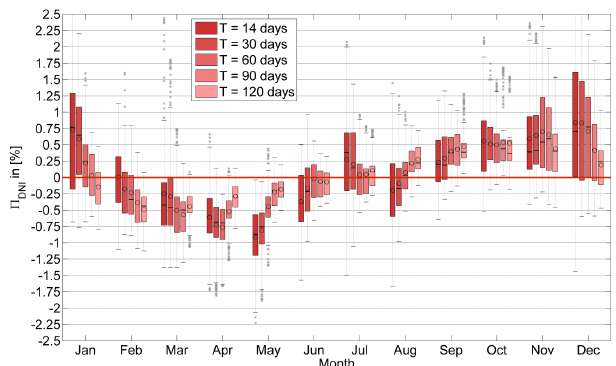
Figure 4. DLR2008: distribution of (cid:53) DNI for T = 14 days, 30 days, 60 days, 90 days and 120 days sorted by calibration starting month. (cid:53) DNI represents the deviation of calibration results from a long- term calibration for DNI.